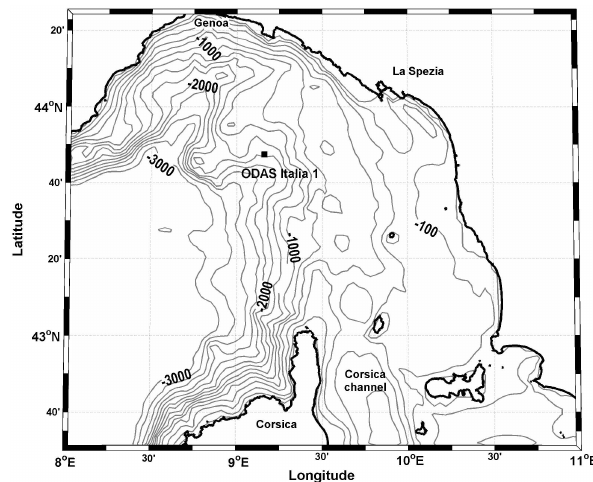
Fig. 1. Map of the Ligurian Sea with the bathimetry. A dot marks the location of the ODAS Italia1 buoy and the